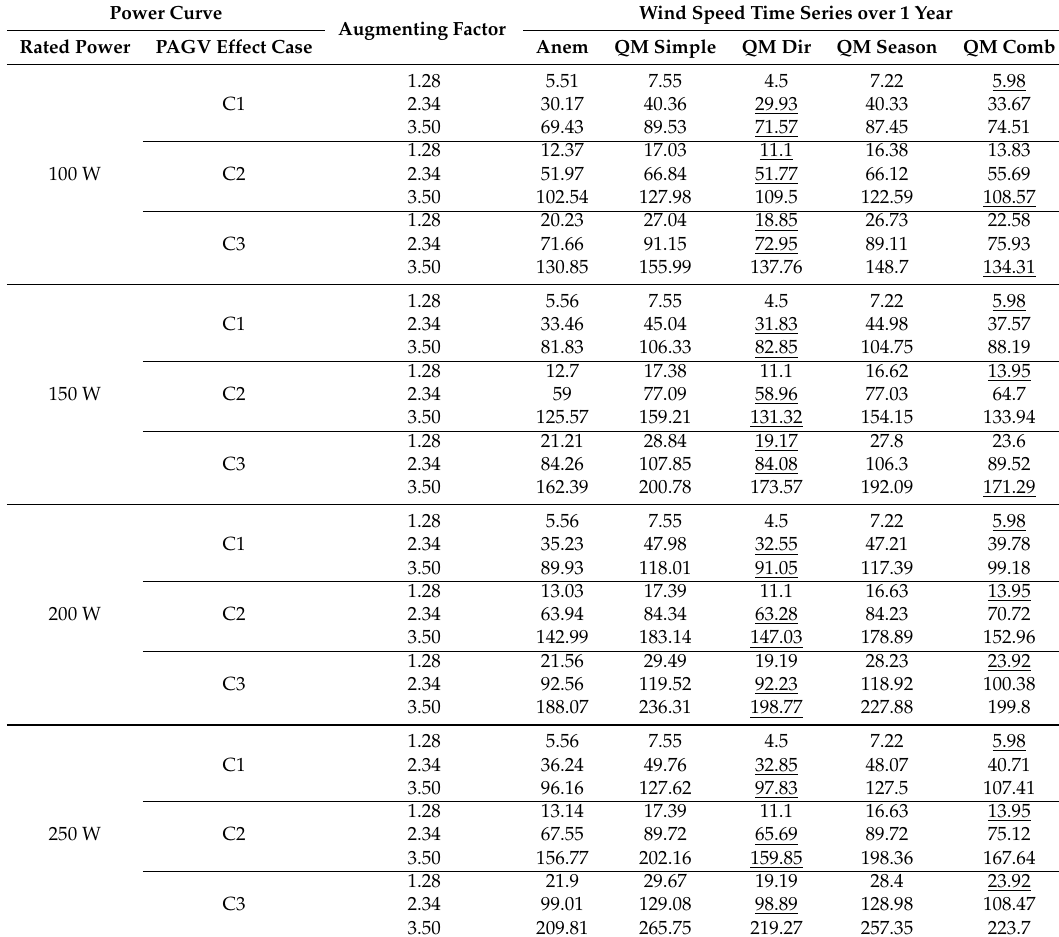
Table 8. Annual Energy Production (AEP) expressed in kWh for all scenarios. The value that is closer to that of the measurements is underlined for each